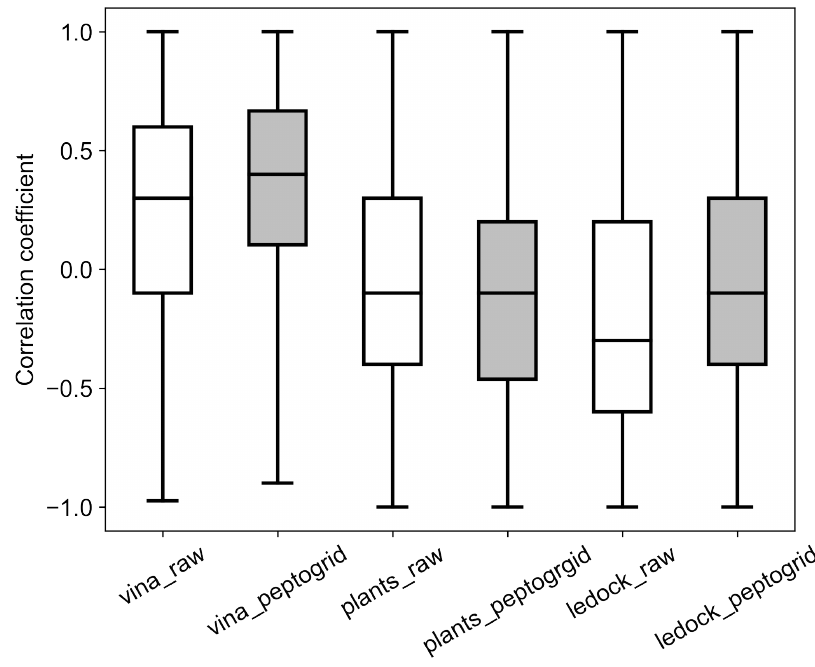
Figure 1. Boostrap analysis of Spearman’s correlation coefficient. PeptoGrid values are in